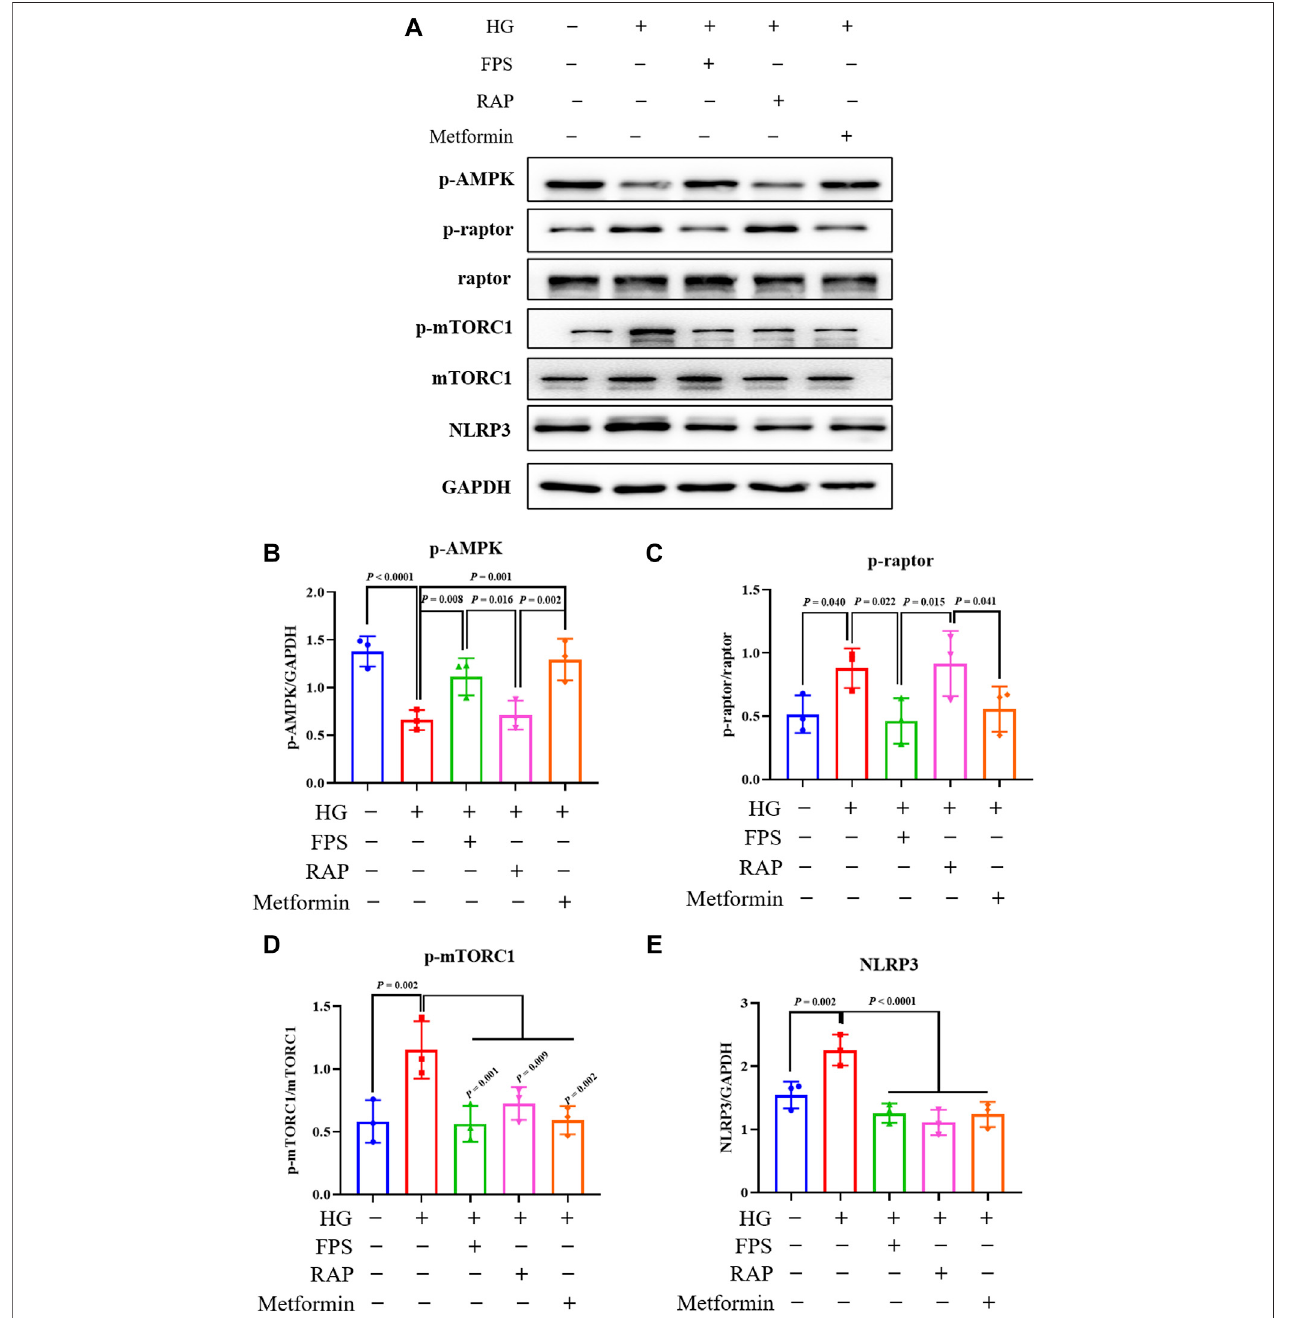
FIGURE 14 | Effects of FPS and RAP on the AMPK/mTORC1/NLRP3 signaling axis in vitro . (A) The WB analysis of the key signaling molecules in the AMPK/ mTORC1/NLRP3 signaling axis in MPC-5 cells exposed to HG with or without FPS or RAP or metformin for 24 h (B – E) The rate of p-AMPK, p-raptor, p-mTORC1, and NLRP3 to GAPDH or raptor or mTORC1, respectively. The data are expressed as the mean ± SD.